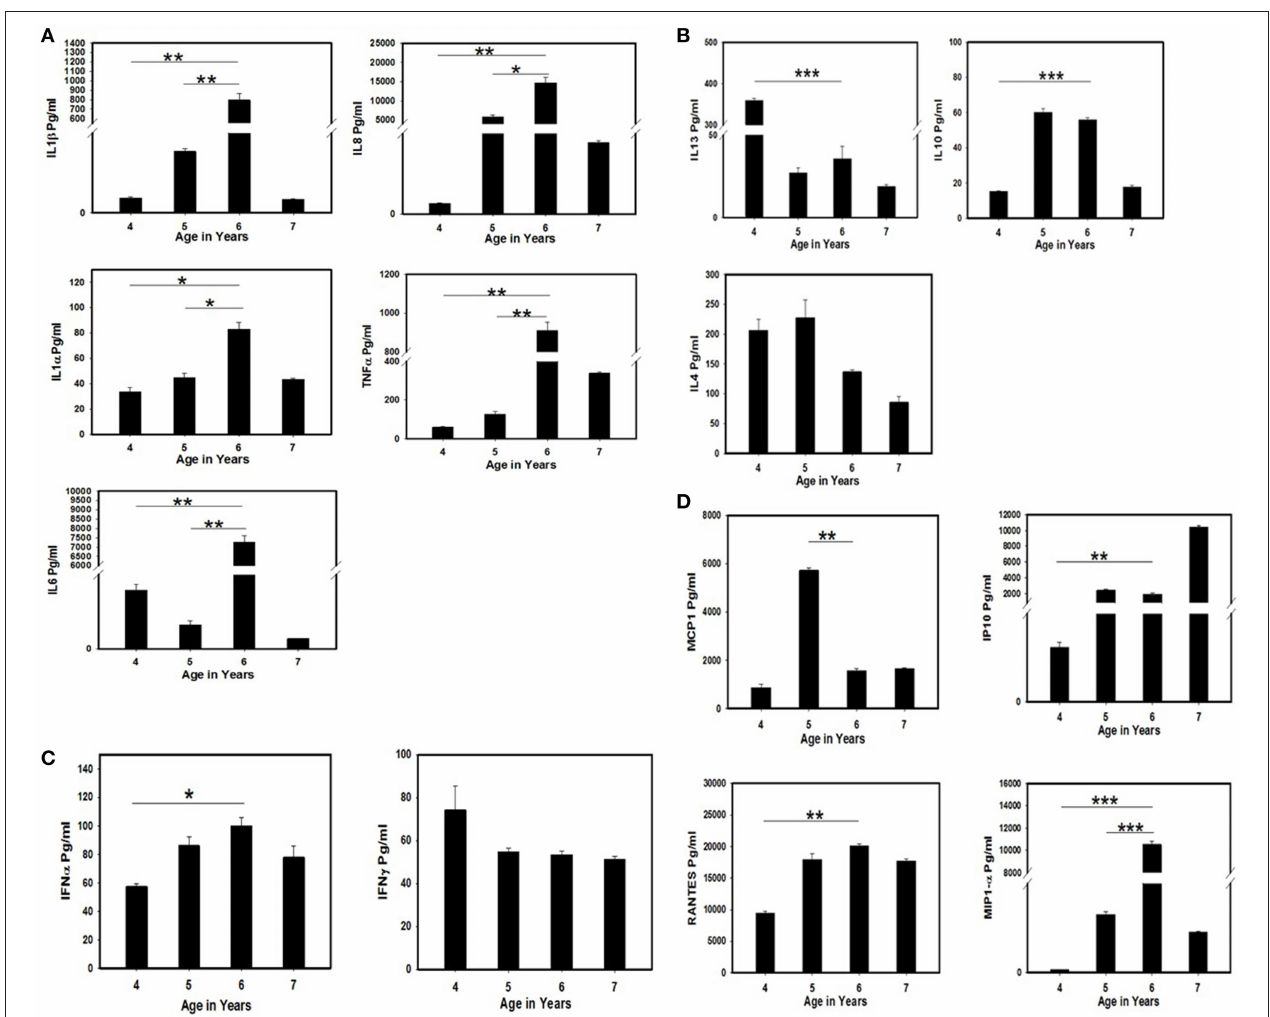
FIGURE 2 | Estimation of cytokine/chemokine levels in the serum samples of the SCID patient tested positive for VDPV3 and abruptly stopped poliovirus shedding after 2 years of continuous excretion at the age of 6 years. The serum samples collected from the child during poliovirus excretion period (4 and 5th year) and after viral clearance (6 and 7th year) were tested by multiplex cytokine ELISA. The assays were performed twice and the mean and standard error were considered for evaluating the statistical significance by Student’s t- test. * represents p < 0.05, ** represent p < 0.01, and *** indicate p < 0.001. (A) Estimation of pro-inflammatory cytokine levels. (B) Estimation of Th2 cytokine levels. (C) Estimation of interferon levels. (D) Estimation of chemokine levels in the SCID patient before and after poliovirus